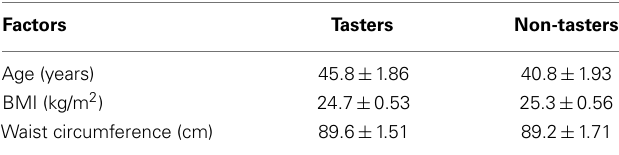
Table 2 | Subject characteristics .